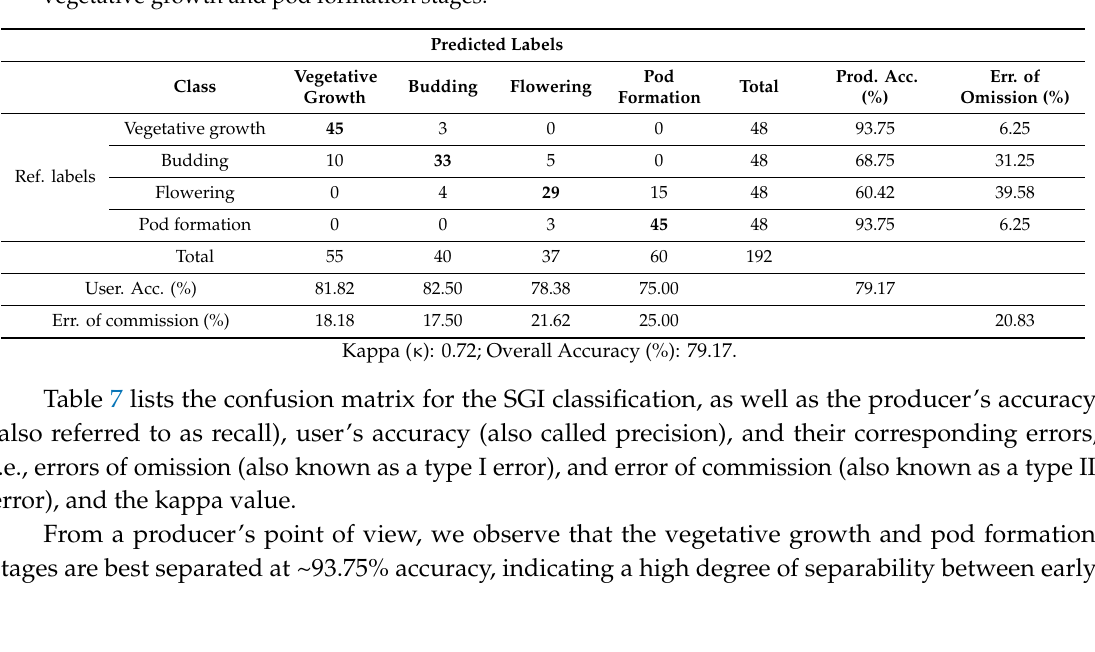
Figure 11. Results from support vector machine (SVM) classification and their corresponding frequency based on wavelengths for SGI, where first wavelength = w1 and second wavelength = w2 in w1 / w2 . ( a ) represents the histogram of the most accurate first wavelengths, while ( b ) depicts the most accurate second wavelengths. Table 7. Confusion matrix for snap bean growth index (SGI). Note the high producer’s accuracy for vegetative growth and pod formation